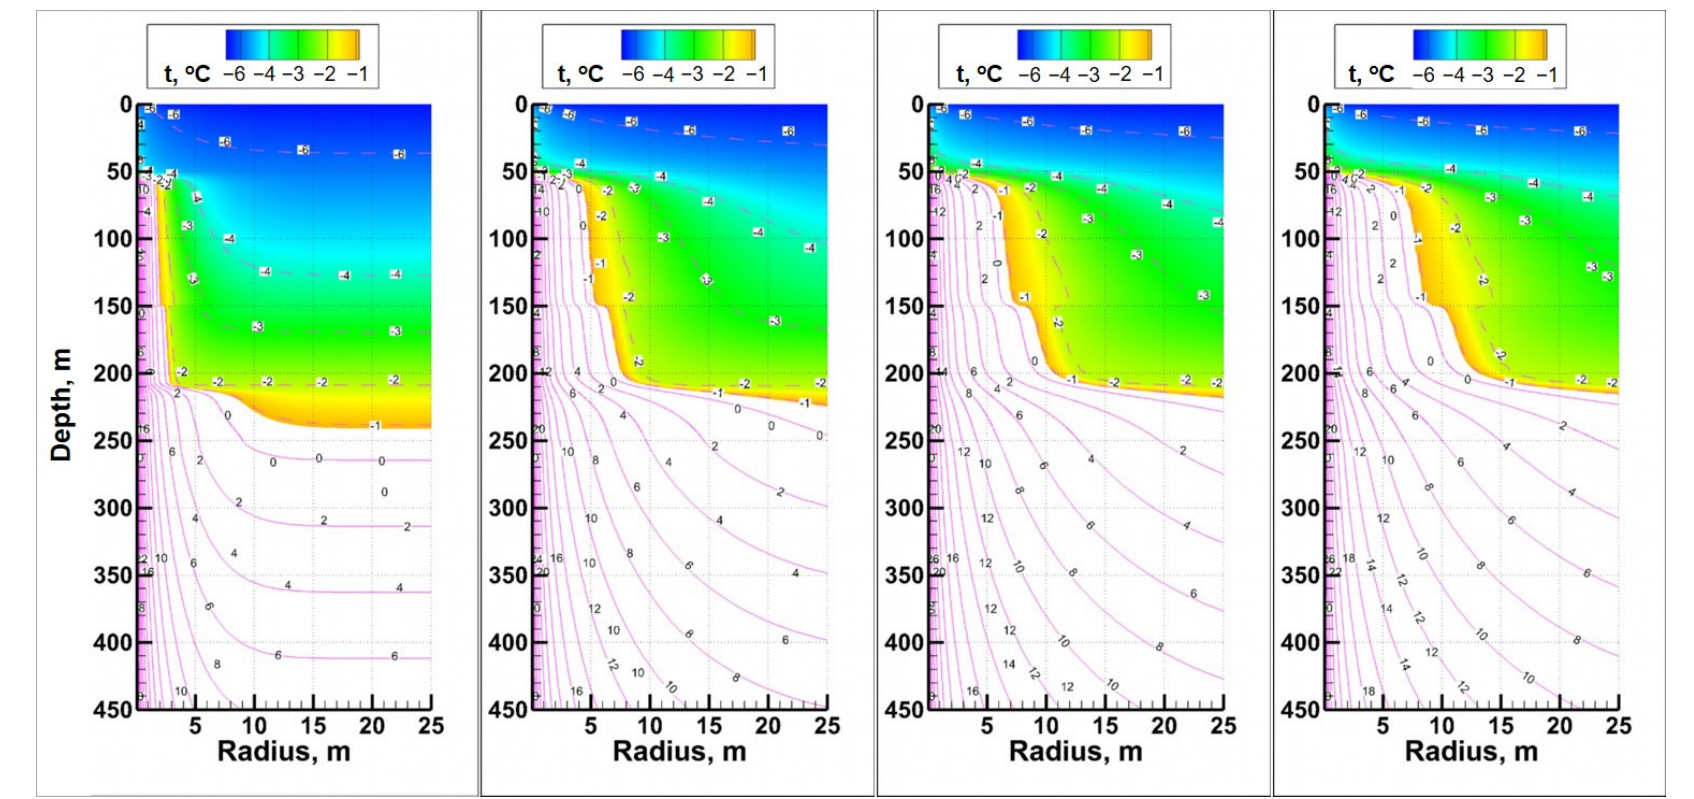
Figure 6. Permafrost temperature variations around a producing gas well (along the radius off the well center) after 1, 10, 20, and 30 years of operation (left to right). Permafrost contains gas hydrates within the depth interval of 60 ‒ 120 m, with hydrate saturation 𝑆 (cid:3035) = 20%; ice saturation 𝑆 (cid:3036) = 80%.